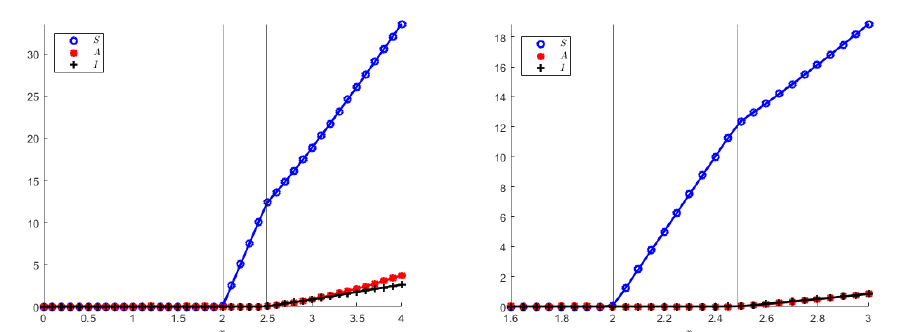
Figure 8. ( Left ): transcritical bifurcations for model (1) obtained with parameter values (72), (55) and initial conditions (50). ( Right ): zoom of the left image showing two bifurcations as r changes; the first from E 0 to E S when r = r 0 = 2 and the second from E S to E SAI when r = r † =